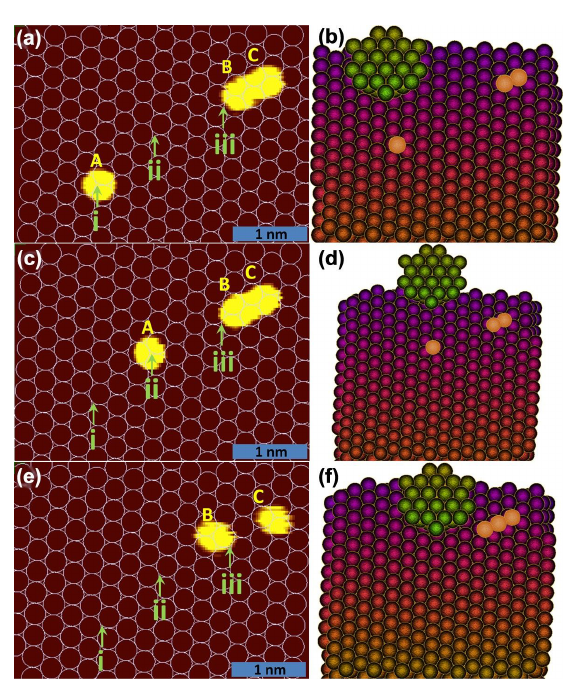
Figure 5: (a, c, e) show the STM images with the topography colour scale tuned to show a smaller apparent size of the adatoms ‘A’, ‘B’ or ‘C’. The scale bar in the bottom-right corner is 1 nm. The other three panels (b, d, f) show the corresponding simulation setup. (a, b) show the initial positions of adatoms ‘A’, ‘B’ and ‘C’ with ‘A’ at position ‘i’. (c ,d) show the position of adatom ‘A’ after the first move and one can see that the adatom arrives at exactly the same position ‘ii’ in both ex- periment and simulation. (e, f) shows the STM image and simulation after the gold atomic chain has been